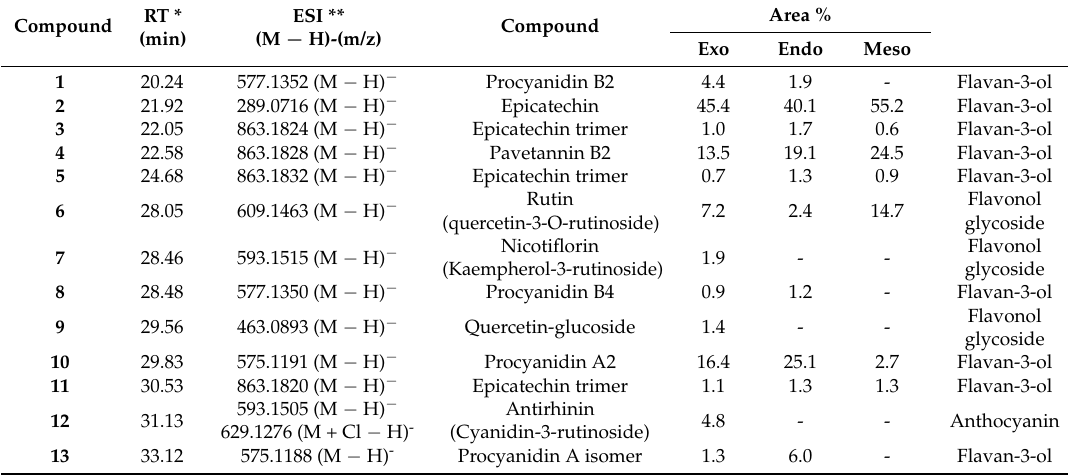
Table 1. Profiles of polyphenols in different litchi